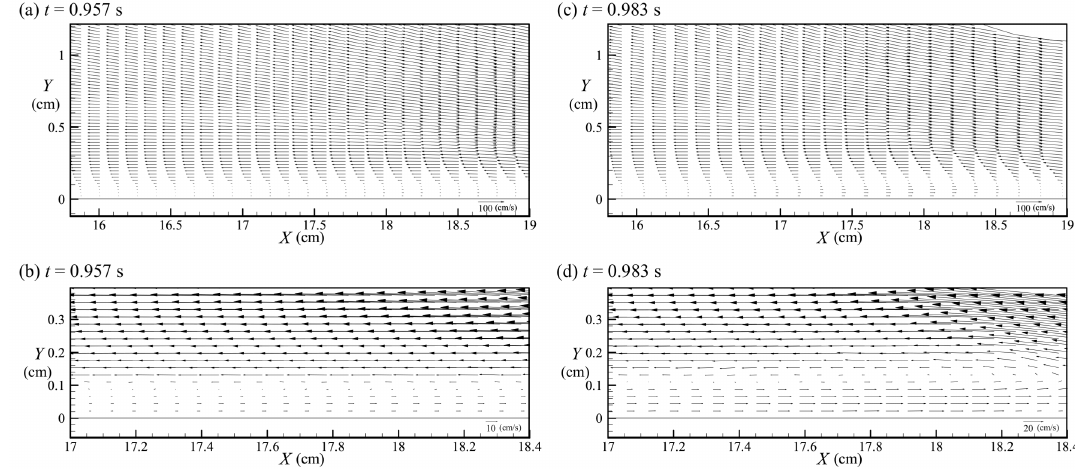
Figure 12. ( a ) Near-bottom velocity field at t = 0.957 s; ( b ) close-up of near-bottom velocity field for ( a ); ( c ) near-bottom velocity field at t = 0.983 s; and ( d ) close-up of near-bottom velocity field for ( c ) (Case